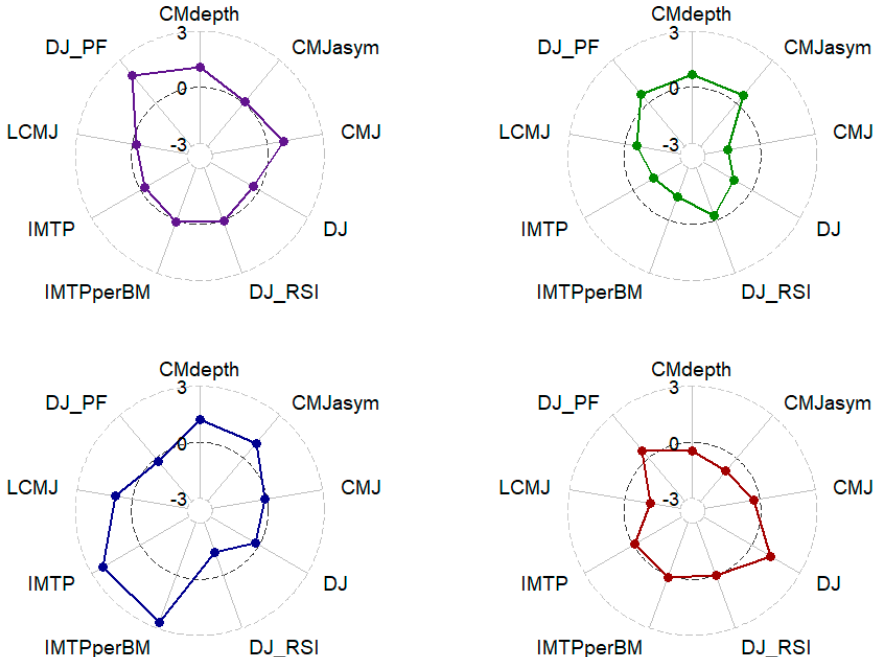
Figure 3. Displayed are the results of force plate assessments of four firefighters (1, purple; 2, green; 3, blue; 4, red) with the results described in case study 1. Data are displayed as standard scores (Z-scores) from − 3 to 3 using radar plots, with the group average being the black dotted line around 0, for unloaded (CMJ) and loaded (LCMJ) countermovement jump height, countermovement depth, (CMdepth), CMJ mean force asymmetry (CMJasym), drop jump height (DJ), DJ peak force (DJ_PF), DJ reactive strength index (DJ_RSI), and absolute (IMTP) and relative isometric mid-thigh pull (IMTP- perBM, IMTP divided by body mass). Data was synthetically generated for visualization